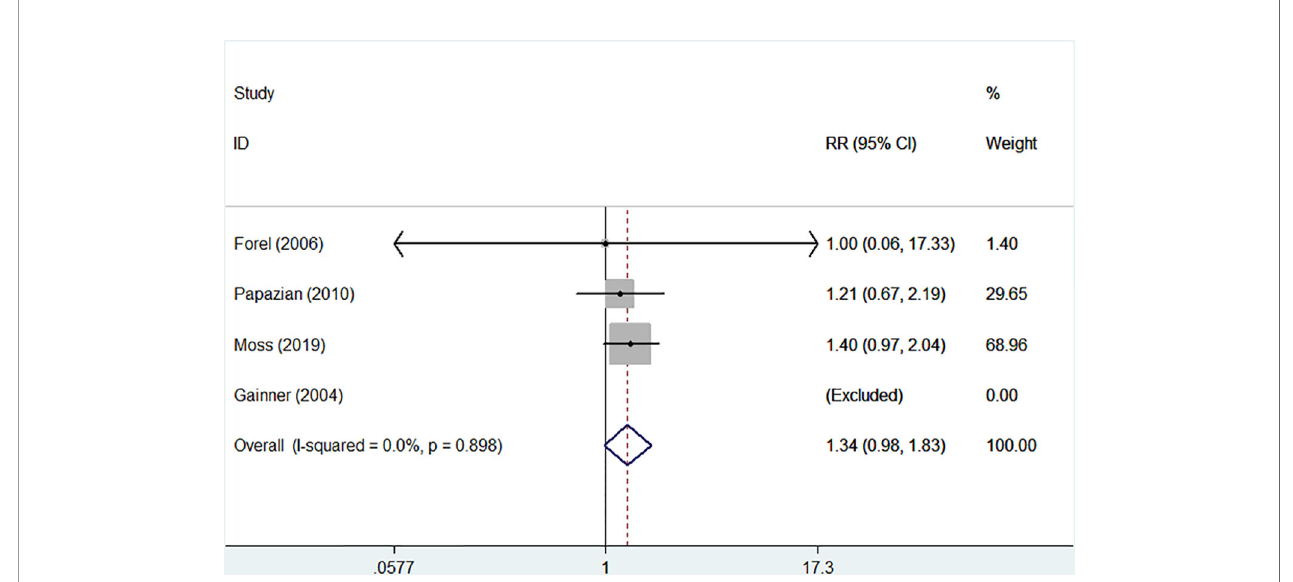
FIGURE 6 | Forest plot of RR and 95% CI for the incidence of ICU-acquired weakness. The incidence of ICU-acquired weakness was described in four studies with 1,437 patients (724 in NMBA group vs. 713 in control group). Infusion of NMBA might increase the risk of ICU-acquired weakness (RR = 1.34, 95% CI 0.98 to 1.84, P = 0.066, I-squared =